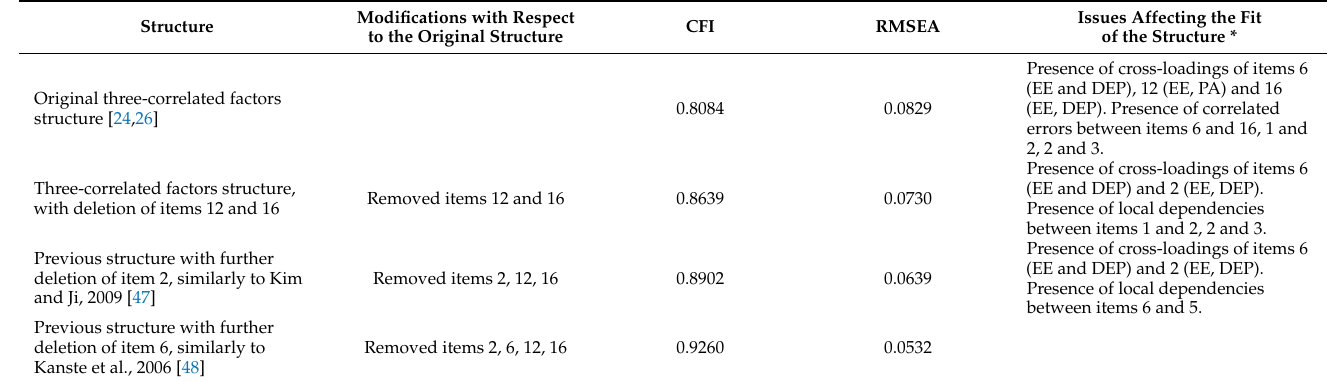
Table 2. Summary of the results of the Confirmatory Factor Analysis of the Maslach Burnout Inventory performed using the sample from the pre-COVID-19 wave (n =